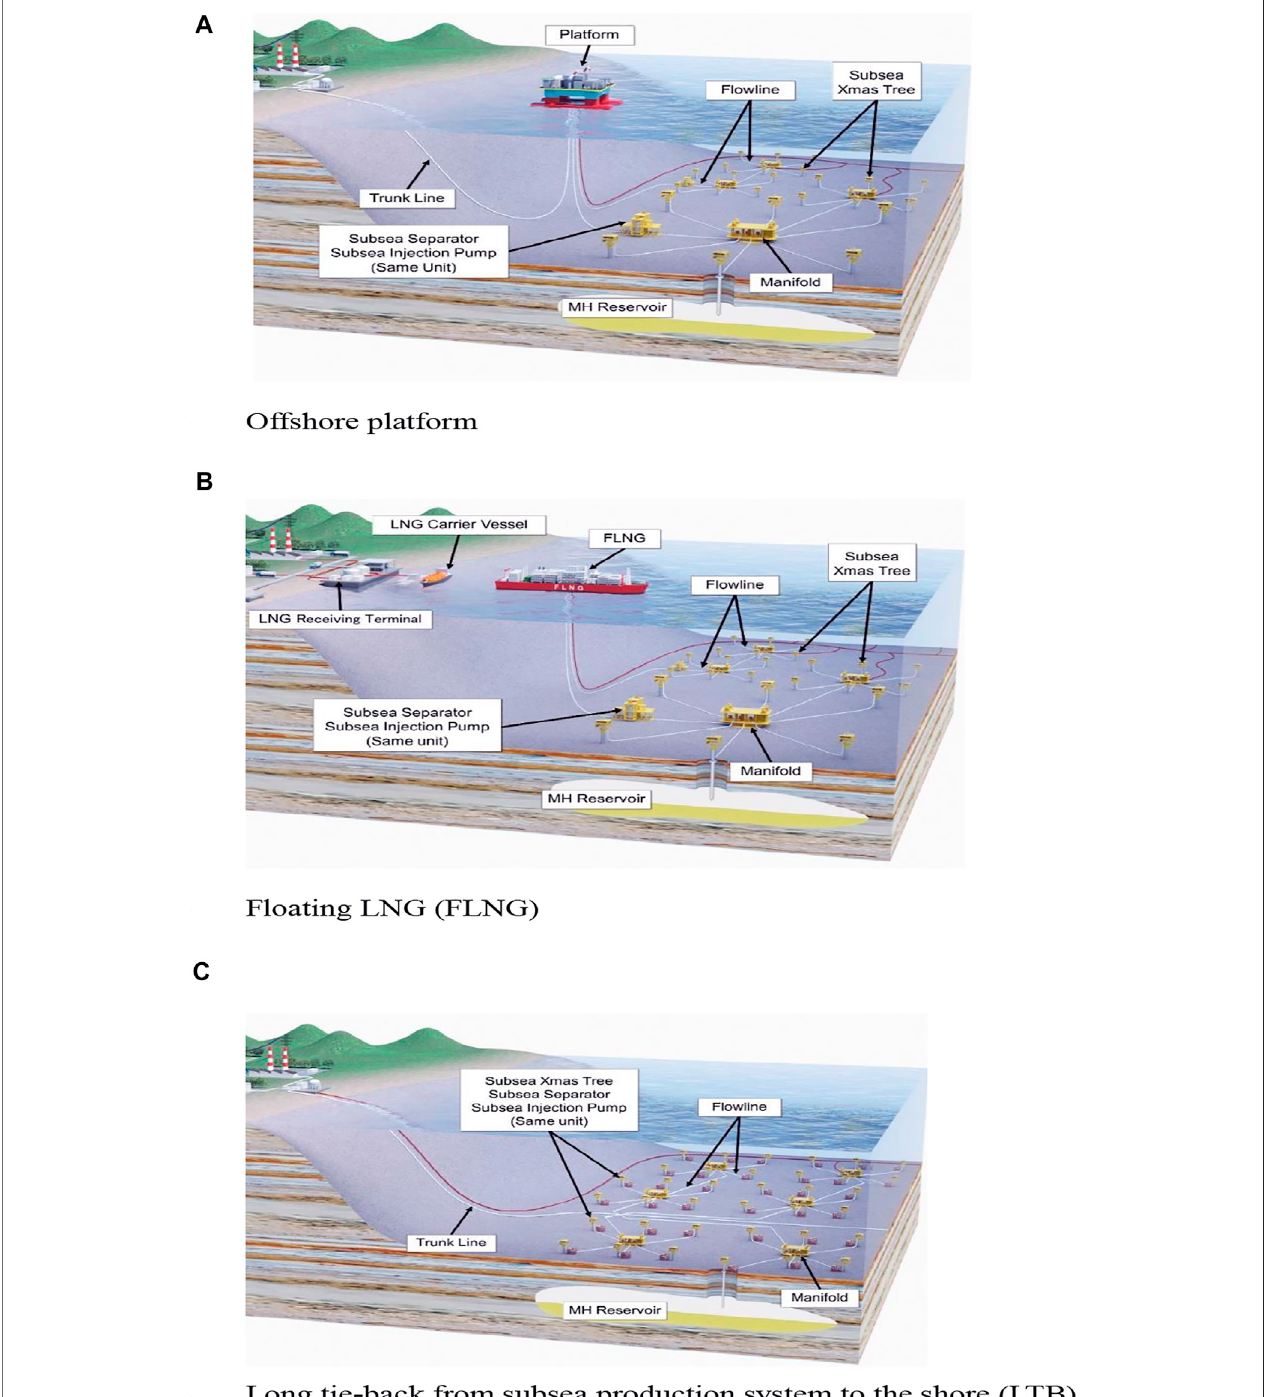
FIGURE6| Threeconceptsofoffshoregasproductionand thetransportsystem.( A )Offshore platform;( B ) fl oating LNG(FLNG); ( C )longtie-back fromthesubsea production system to the shore (LTB)